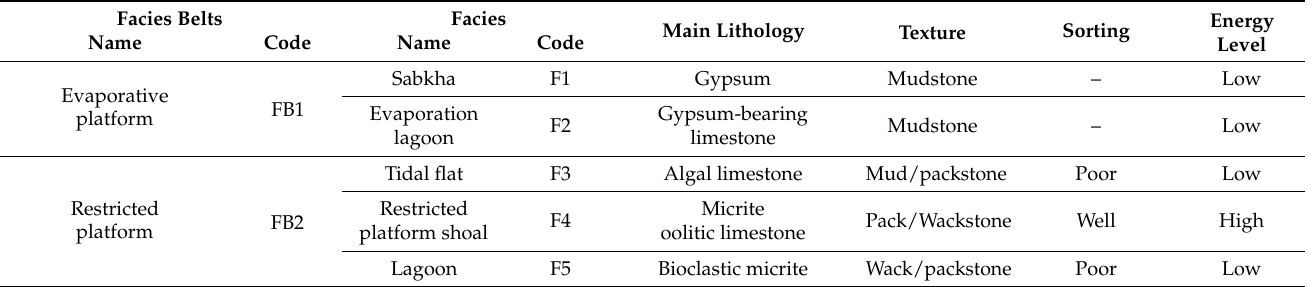
Table 1. Facies characteristics of the Callovian-Oxfordian